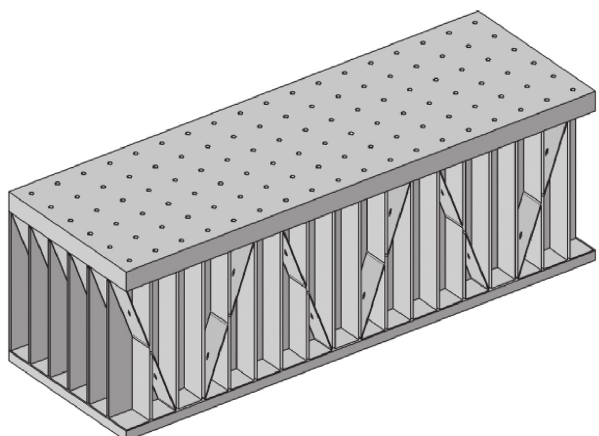
Figure 1: Perforated honeycomb-corrugation sandwich panel metamaterial structure.